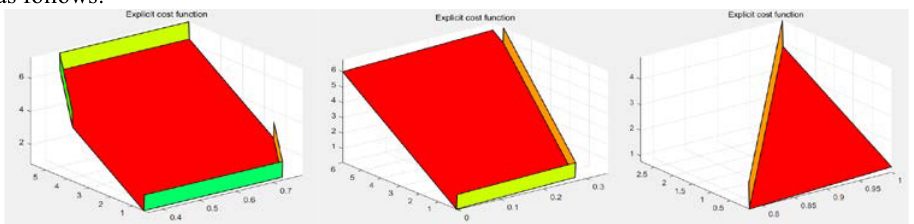
Fig. 5. Explicit control solution partition.